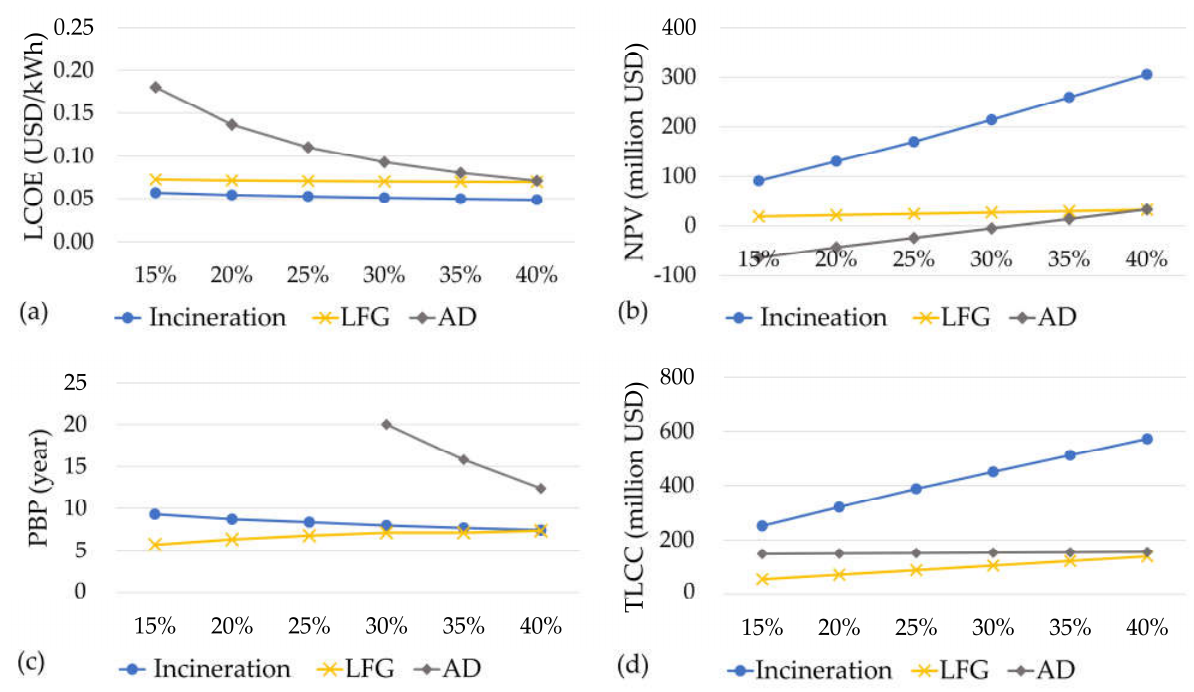
Figure 5. Influence of electricity generation efficiency on ( a ) LCOE, ( b ) NPV, ( c ) PBP, and ( d ) TLCC.